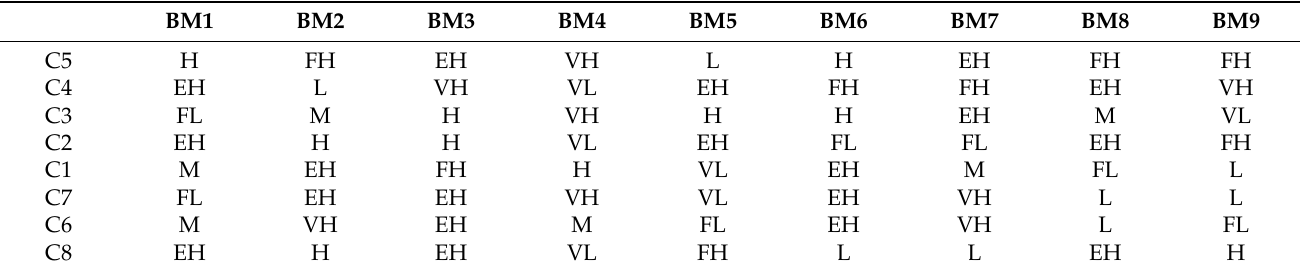
Table 4. Representative evaluations of alternatives in relation to